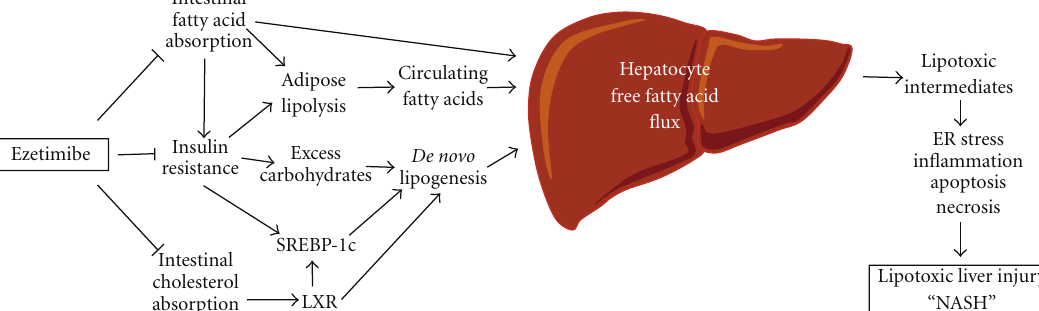
Figure 6: Potential therapeutic e ff ects of ezetimibe on nonalcoholic fatty liver disease and steatohepatitis (NAFLD and NASH). On the basis of the lipotoxicity model of NAFLD and NASH [51], it has been proposed that metabolites of unesterified fatty acids may induce lipotoxic hepatocellular injury manifested as ER stress, inflammation, apoptosis, necrosis, and dysmorphic features such as ballooning and